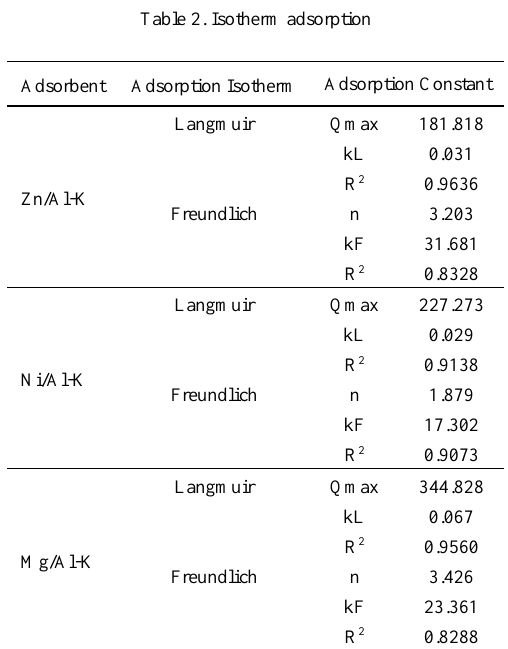
Table 2. Isotherm